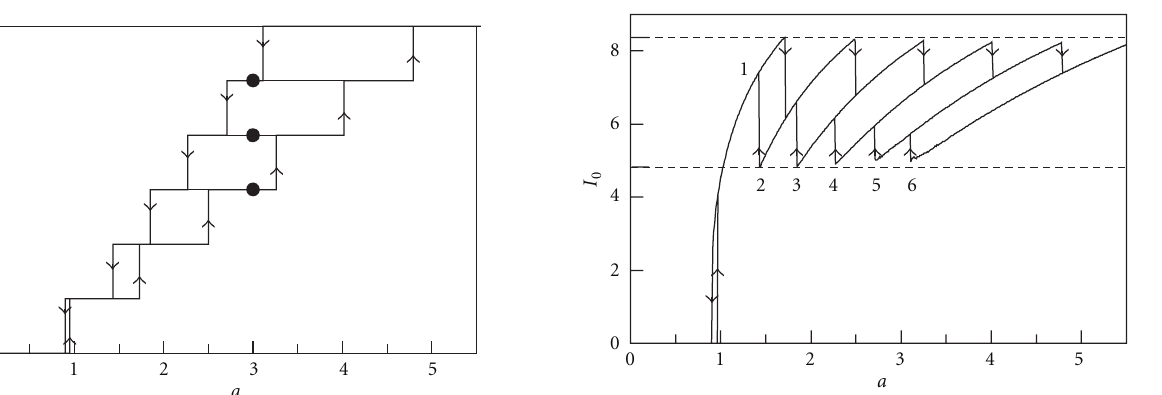
Figure 3: Multihysteresis dependence of the number of pulses N in established stationary operation on pumping a .